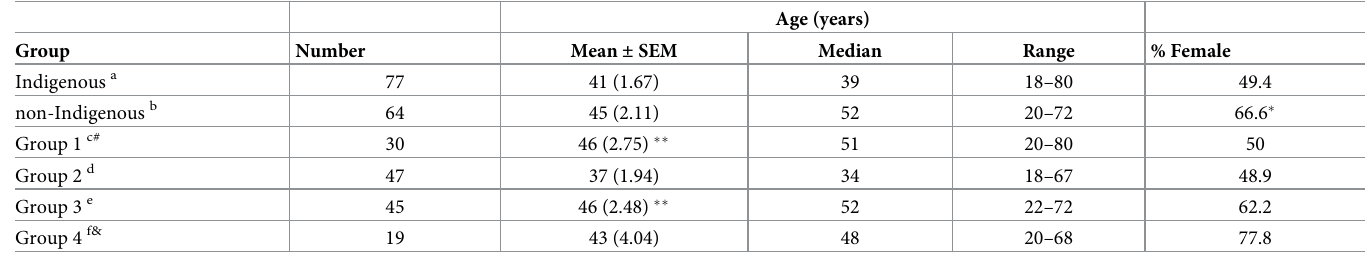
Table 1. Participant